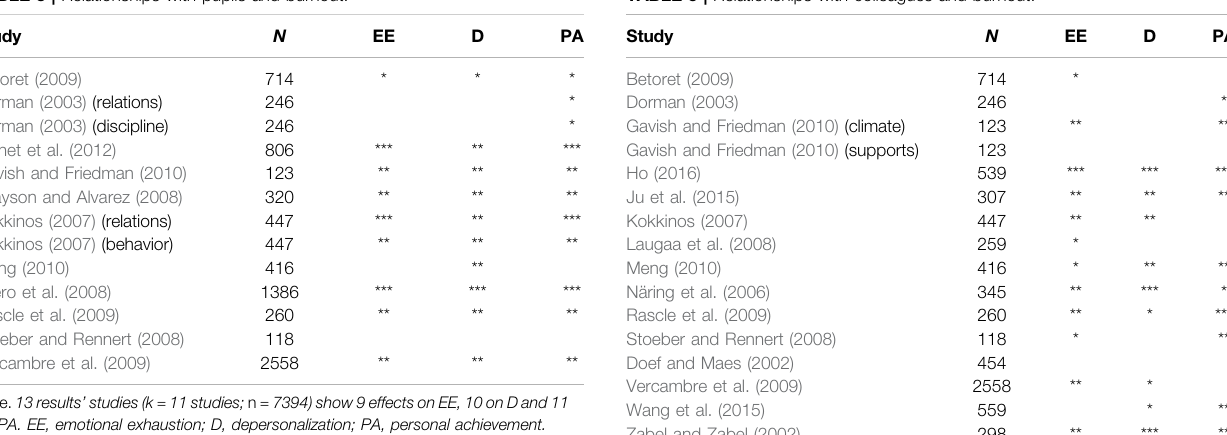
TABLE 5 | Relationships with colleagues and burnout.